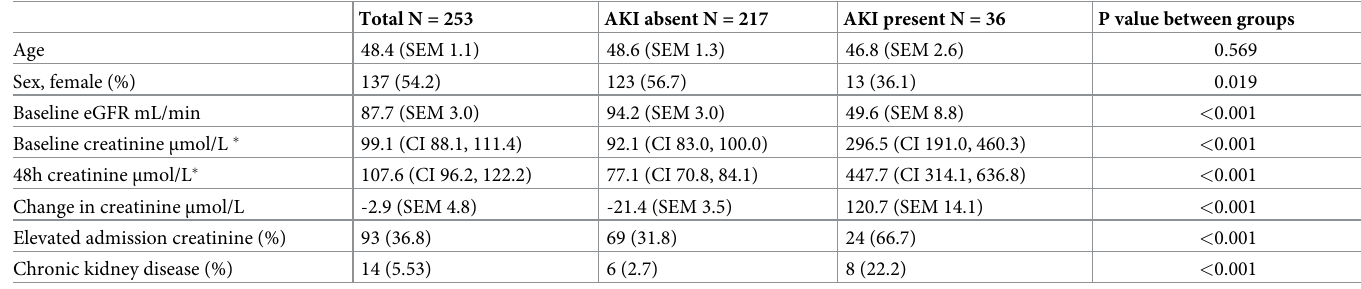
Table 1. Renal function recorded at baseline and at 48 hours after admission for the group with AKI, those without AKI and for the total study population. Total N =